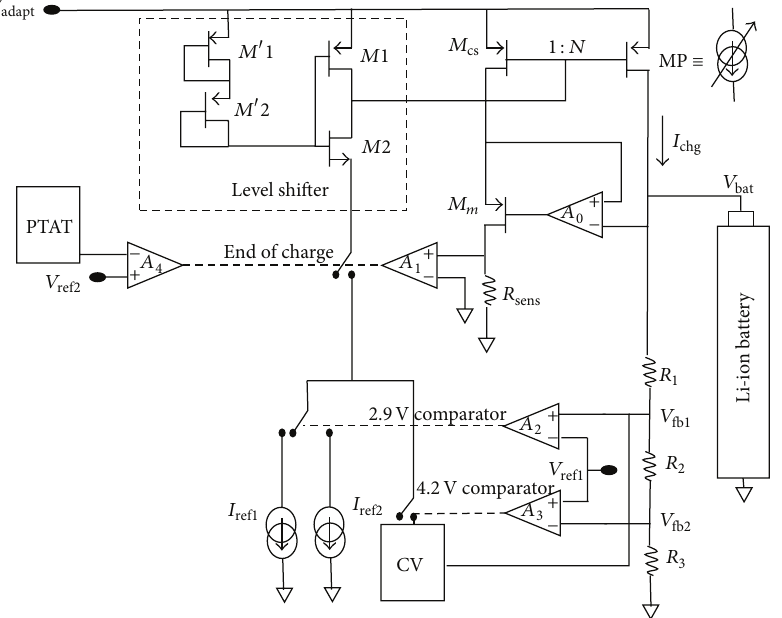
Figure 3: Simplified diagram of the proposed Li-ion battery